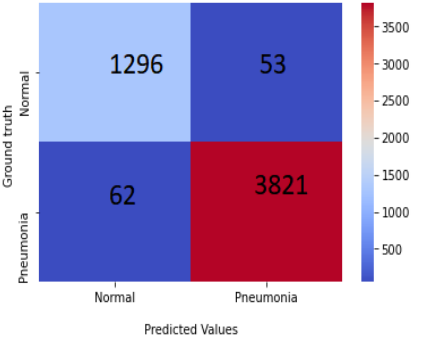
Figure 8. Confusion matrix of PNA-GCN on test